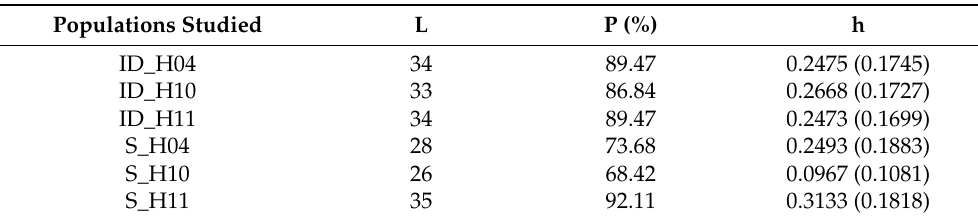
Table 2. Estimators of genetic diversity for the grape populations of S. cerevisiae in vineyards ID and S across H04, H10, and